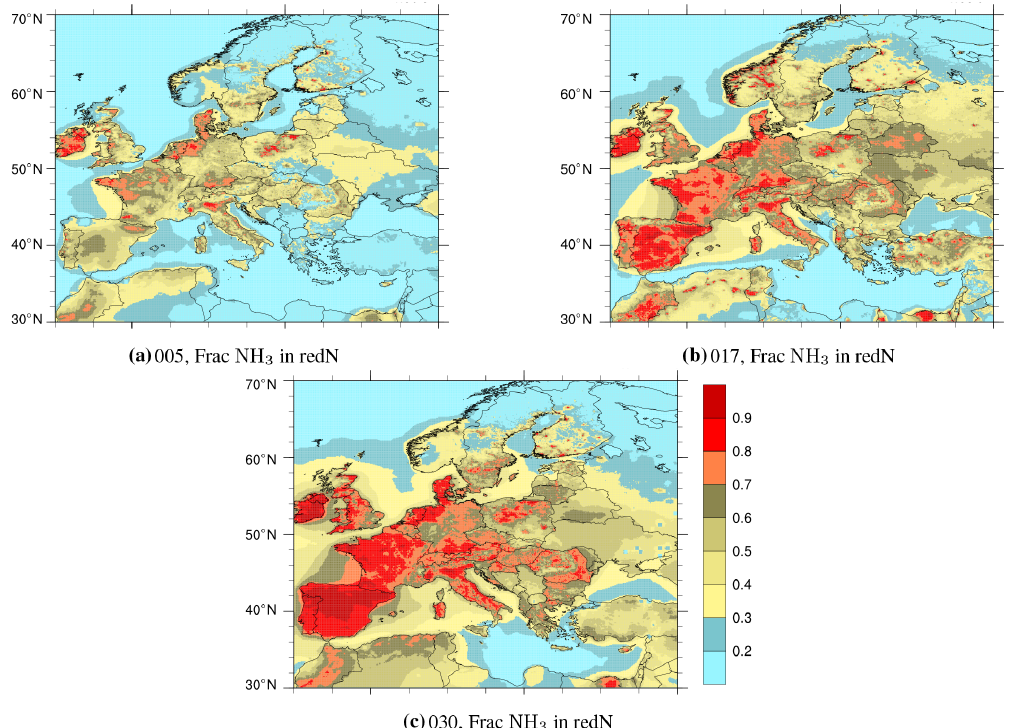
+ ) in 2005, 2017, and 4